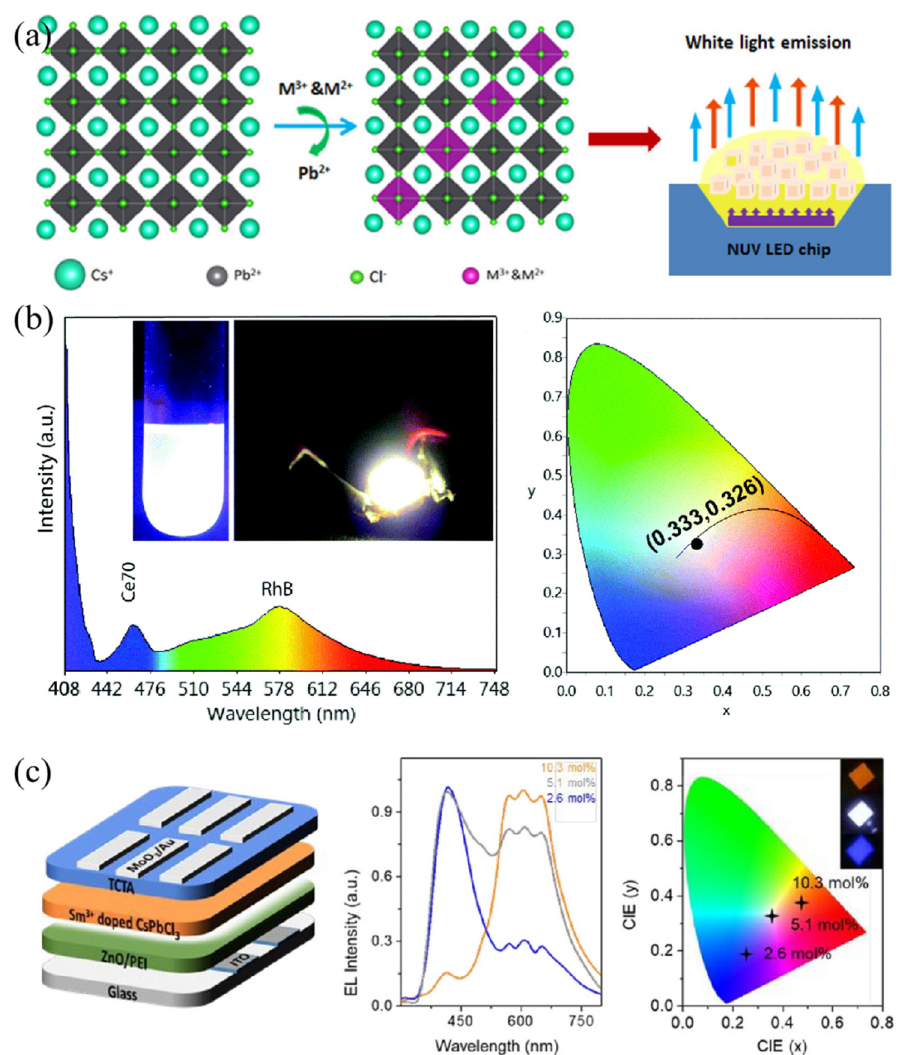
Figure 7. ( a ) Crystal structure of CsPbCl x Br 3-x with co-doping metal ion pairs (M 3+ /M 2+ ) and the white LED combining CsPbCl 1.8 Br 1.2 :Ce 3+ /Mn 2+ and ultraviolet chip (Reprinted/adapted with permission from Ref. [76]. Copyright 2018 American Chemical Society); ( b ) EL spectrum, white light emission photograph and CIE chromaticity coordinates of WLED based on UV LED chip, Ce 3+ :CH 3 NH 3 PbBr 3 , and Rhodamine B (Reprinted/adapted with permission from Ref. [78]. Copyright 2021 Royal Society of Chemistry); ( c ) Device structure, EL spectra, and CIE coordinates for perovskite WLED based on Glass/PEI/Sm 3+ :CsPbCl 3 /TCTA/MoO 3 /Au (Reprinted/adapted with permission from Ref. [79]. Copyright 2020 American Chemical Society).